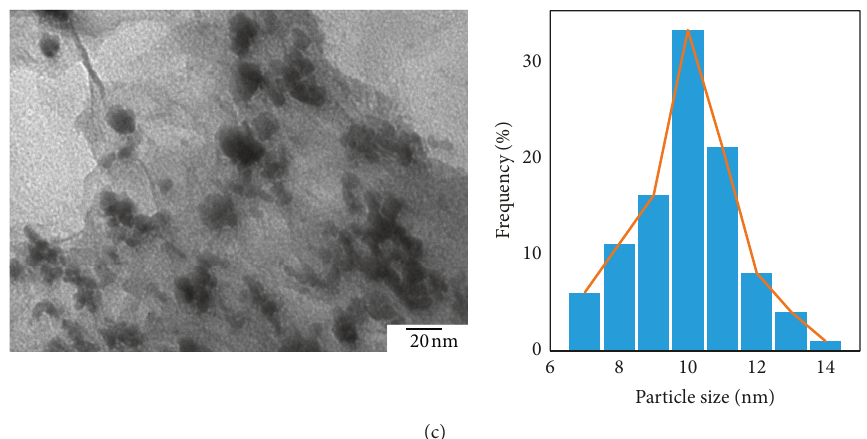
Figure 6: TEM images and particle size distributions of PASG.E (a), PASG.N (b), and PASGN.N (c) catalysts with different magnifications.